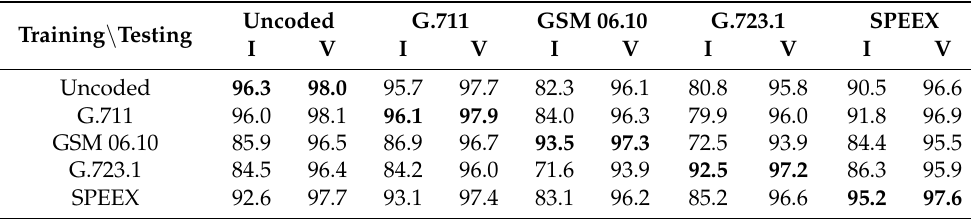
Table 2. Results of speaker identification (I) and verification (V) effectiveness for the common coding